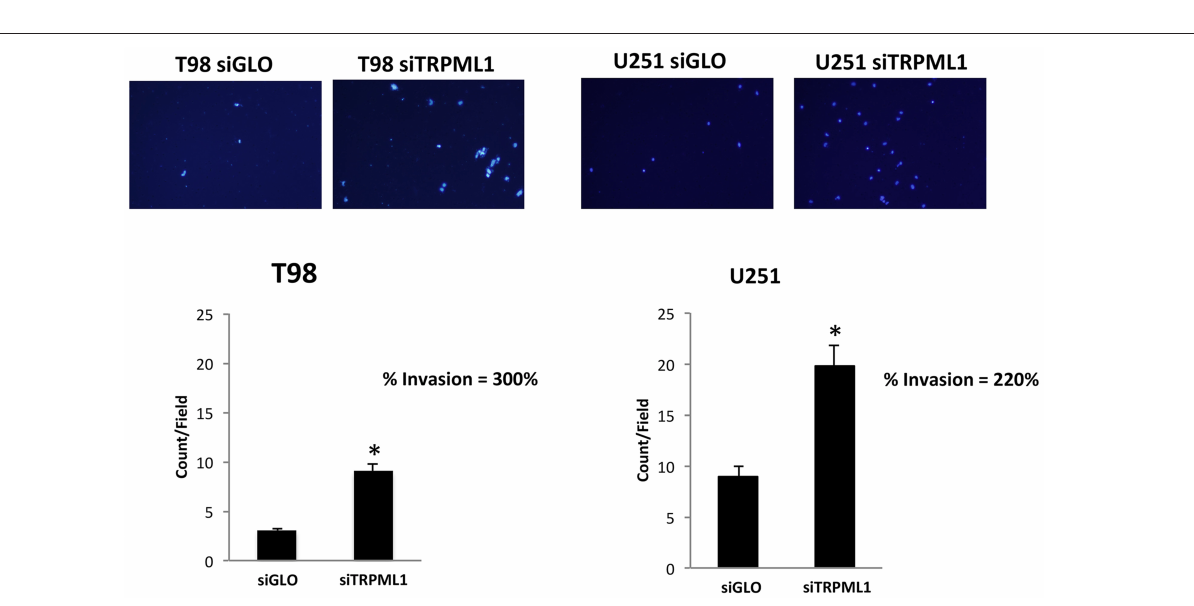
FIGURE 6 | levels were measured in WCL by Western blot and normalized to β -actin. Cathepsin B levels were measured in C fraction by Western blot and normalized to β -actin. Densitometric data shown are expressed as mean ± SE of three separate experiments. * p < 0.05. (C) Cathepsin B activity was measured in siGLO and siTRPML1 T98 and U251 cells. * p < 0.05. (D) siTRPML1 T98 and U251 cells were treated with the inhibitor BAF A1 (25nM) for 48h. The Western blot analysis of pro-cathepsin B and mature cathepsin B protein levels was performed. Blots are representative of one of three separate experiments. β -actin was used as loading control. (E) Caspase-3 activity was measured in siGLO, and siTRPML1 T98 cells treated or not with the cathepsin inhibitor Ca074Me. FU, fluorescence units. * p < 0.001vs. untreated siGLO, # p < 0.05 Ca074Me-treated siTRPML1 vs. Ca074Me-treated siGLO cells. (F) Representative flow cytometric profiles of siTRPML1 U251 cells treated or not with Ca074Me and then stained with C12FDG. Gray curve represents unstained cells. MFI, mean fluorescence intensity.